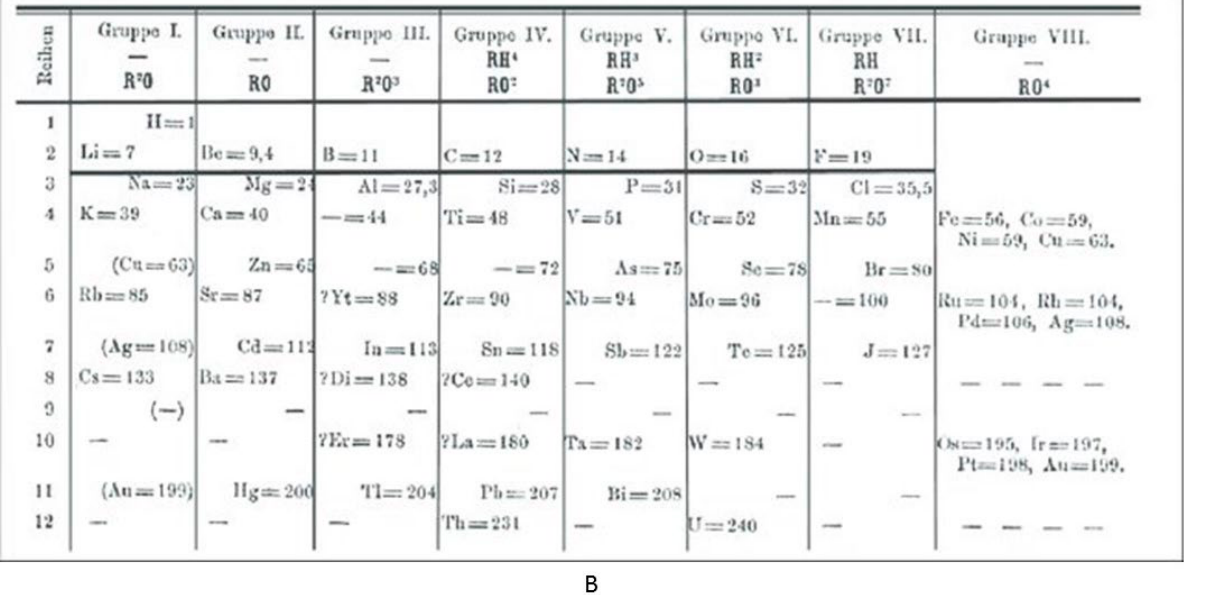
Figure 2b. Mendeleev’s periodic tables by 1871. B) as in his Table II in his publication, D. Mendeleev, Die periodische Gesetzmässigkeit der chemischen Elemente , Ann. Chem. Pharm. 1871, 8 (Supplementband).